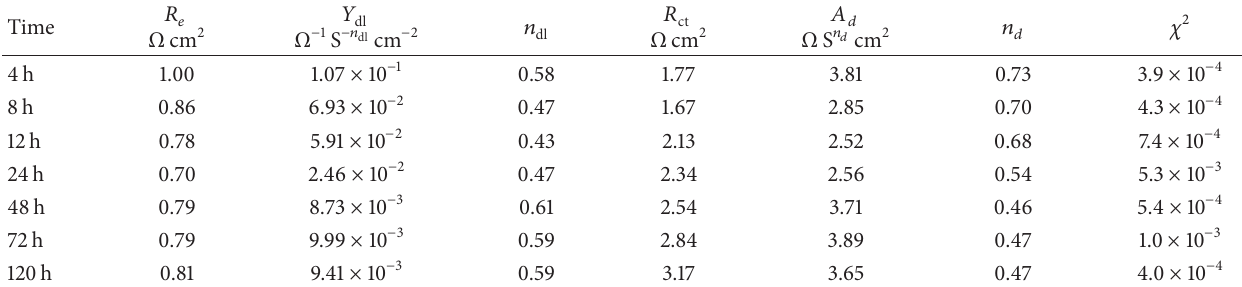
Figure 5: SEM morphology of SS304 ((a) and (b)) after 120h of corrosion in molten carbonate. (b) is the enlarged figures in the rectangles for (a). (c) is the EDX composition profile across the line in (b). Table 3: Results of the CNLS fit to EIS data of